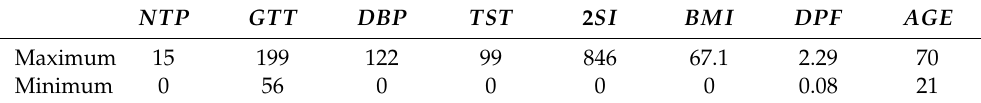
Table 10. Bounding box defined by the maximum and minimum of each feature in the input